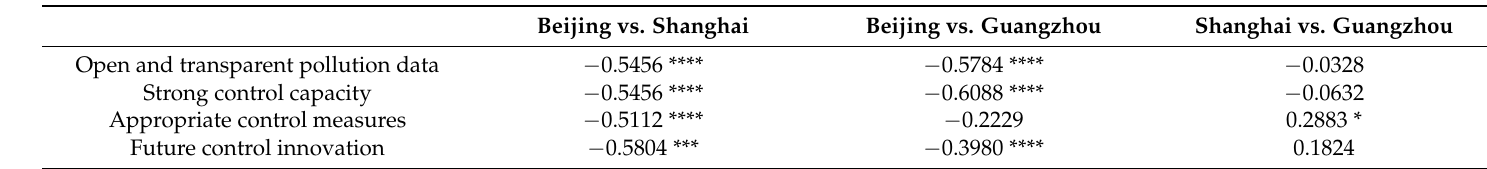
Table 6. ANOVA analysis of political trust among Beijing, Shanghai, and Guangzhou. Beijing vs.